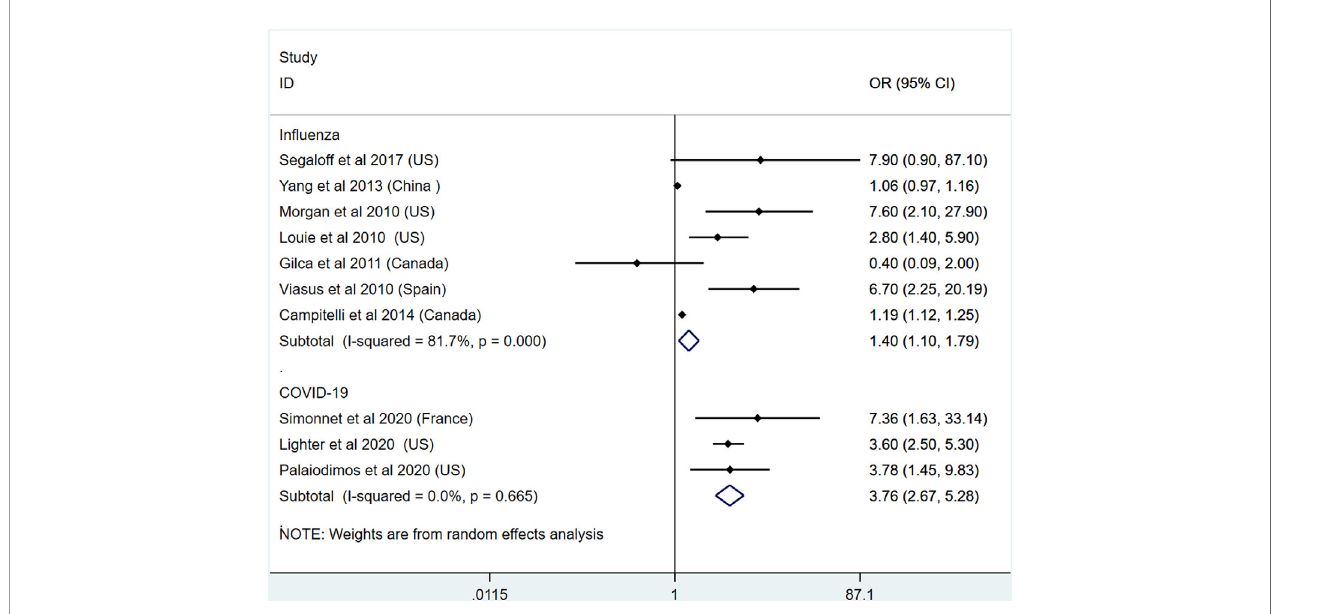
FIGURE 7 | Odds ratios for severe outcome and mortality in patients with morbid obesity and in fl uenza or